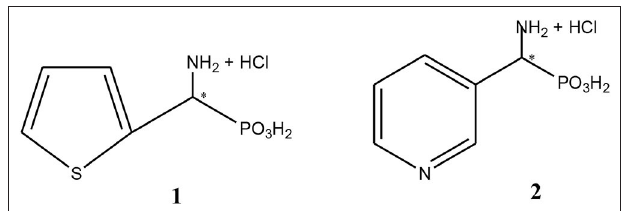
FIGURE 1 | Chemical structures of 1-amino-1-(2-thienyl)methylphosphonic acid, substrate 1 and 1-amino-1-(3 ′ pirydyl)methylphosphonic acid, substrate